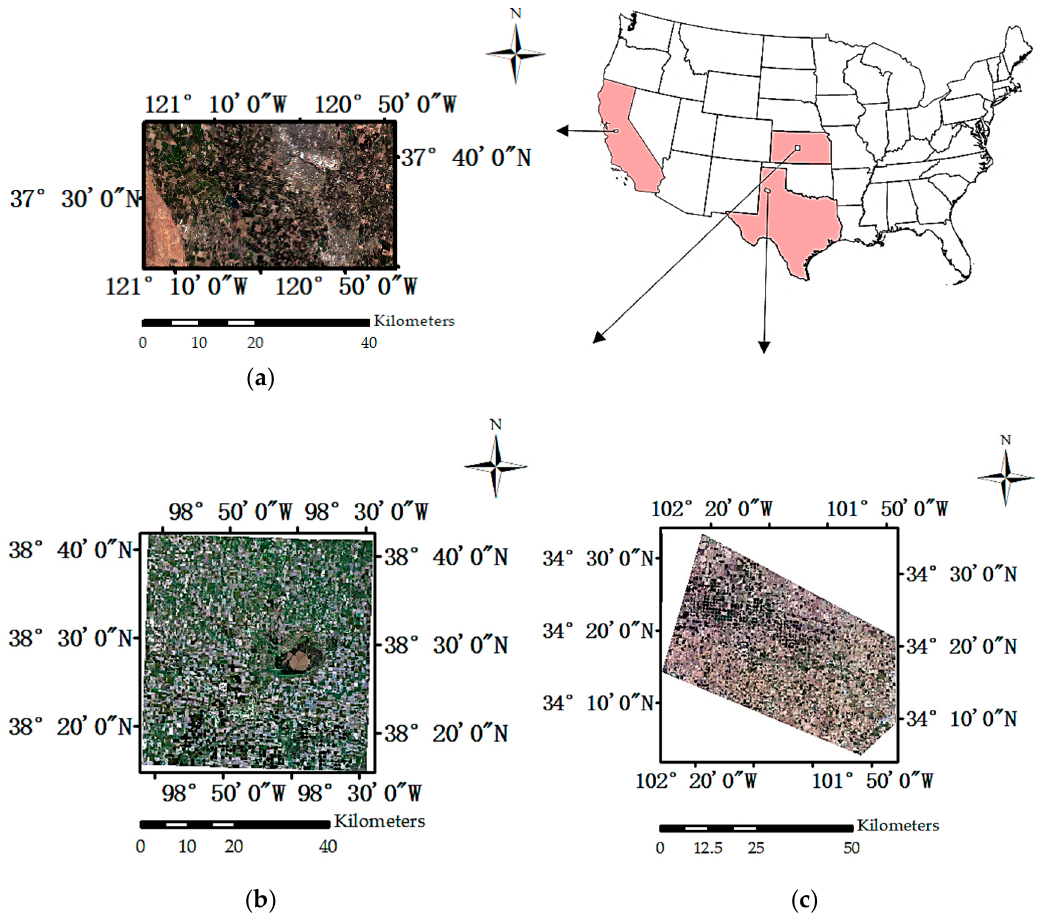
Figure 1. Location of the study sites: ( a ) Landsat 8 image of study area 1 in California taken on 25 July 2017, ( b ) Landsat 8 image of study area 2 in Kansas taken on 20 July 2016, and ( c ) Landsat 8 image of study area 3 in Texas taken on 4 July 2019. Table 1. Average temperature of the study areas.